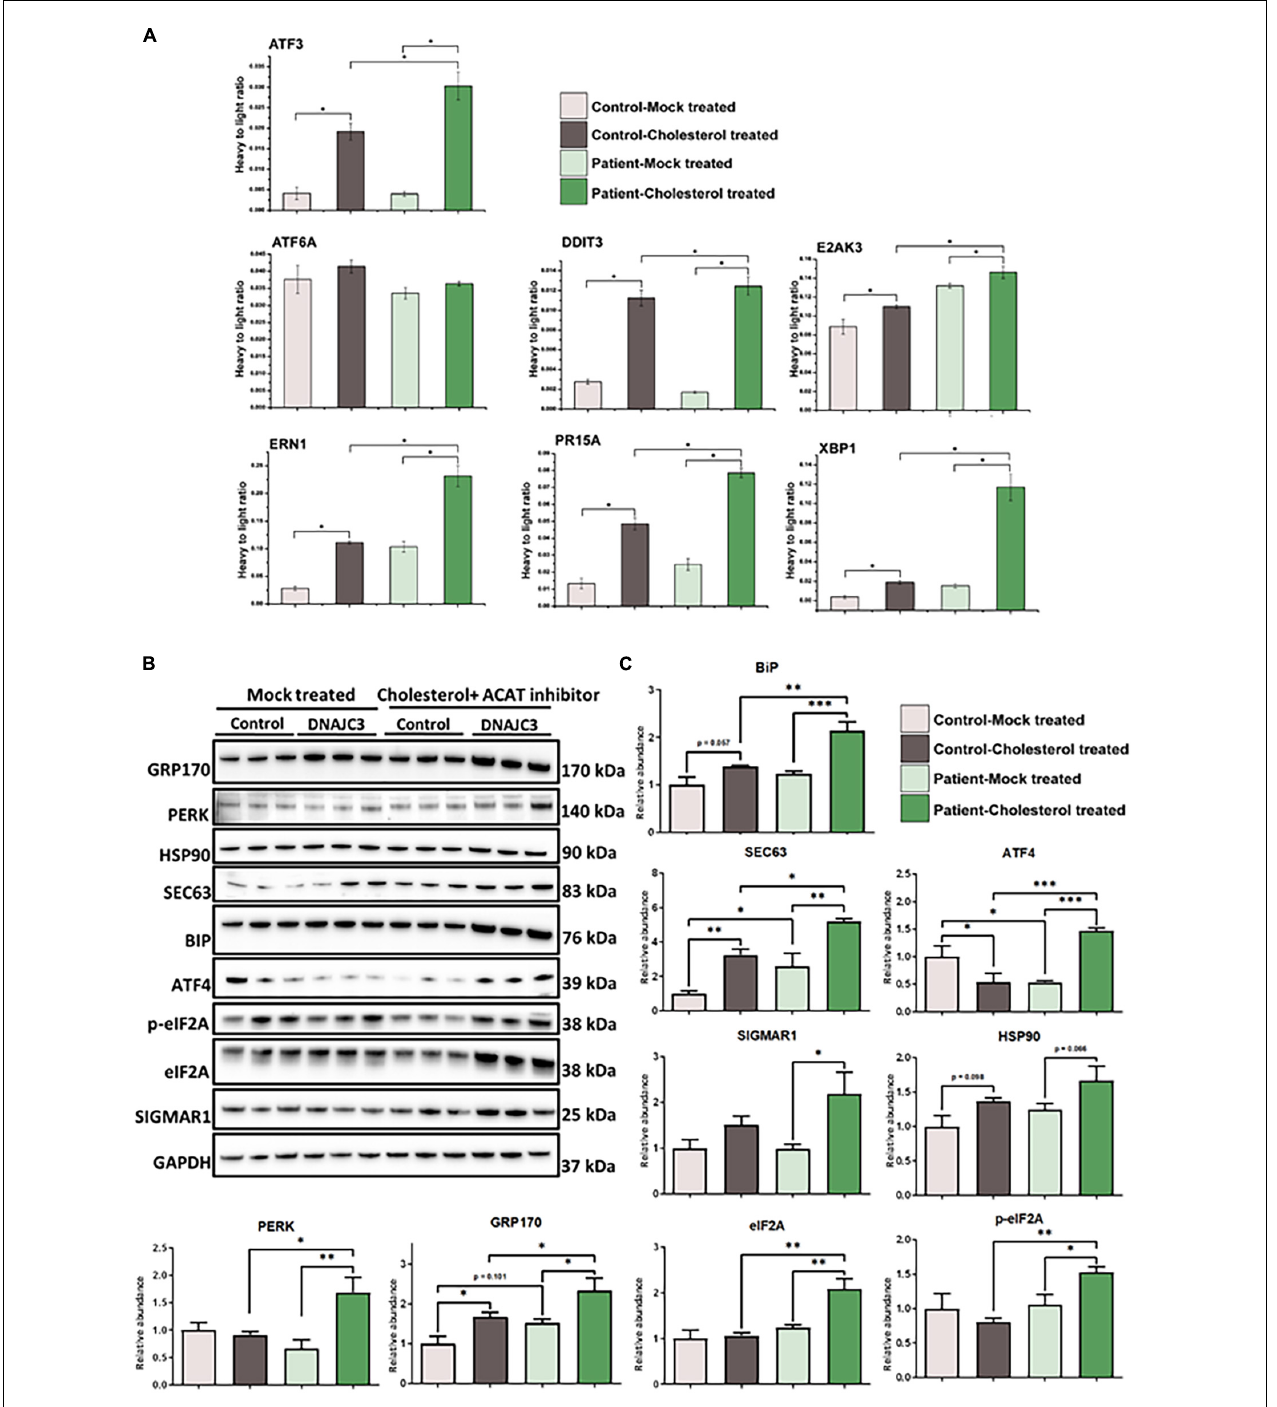
FIGURE 3 | Endoplasmic reticulum (ER) stress in DNAJC3 mut fibroblasts. (A) Mean values (two technical and two biological replicates for each sample type, respectively) of PRM-based quantification of known ER stress-related proteins following treatment with either DMSO (mock) or soluble cholesterol + ACAT inhibitor in patient and control fibroblasts, respectively. Cholesterol treatment and concomitant inhibition of cholesterol acyltransferase (ACAT; esterifies cholesterol) resulted in pronounced ER stress in both DNAJC3 mut and control fibroblasts. Notably, significantly greater increases in ER stress protein expression was seen following soluble cholesterol treatment for ATF3 ( p = 0.026), DDIT3 ( p = 0.031), ERN1 ( p = 0.049), PR15A ( p = 0.028), and XBP1 ( p = 0.003) in treated DNAJC3 mut cells. Student’s t -tests compared either mock-treated or cholesterol-treated control versus the correspondingly treated DNAJC3 mut fibroblasts. Student’s t -test ( n = 2) of changes between mock-treated and cholesterol-treated expression levels is statistically significant between mock-treated DNAJC3 mut versus control fibroblasts for ATF3